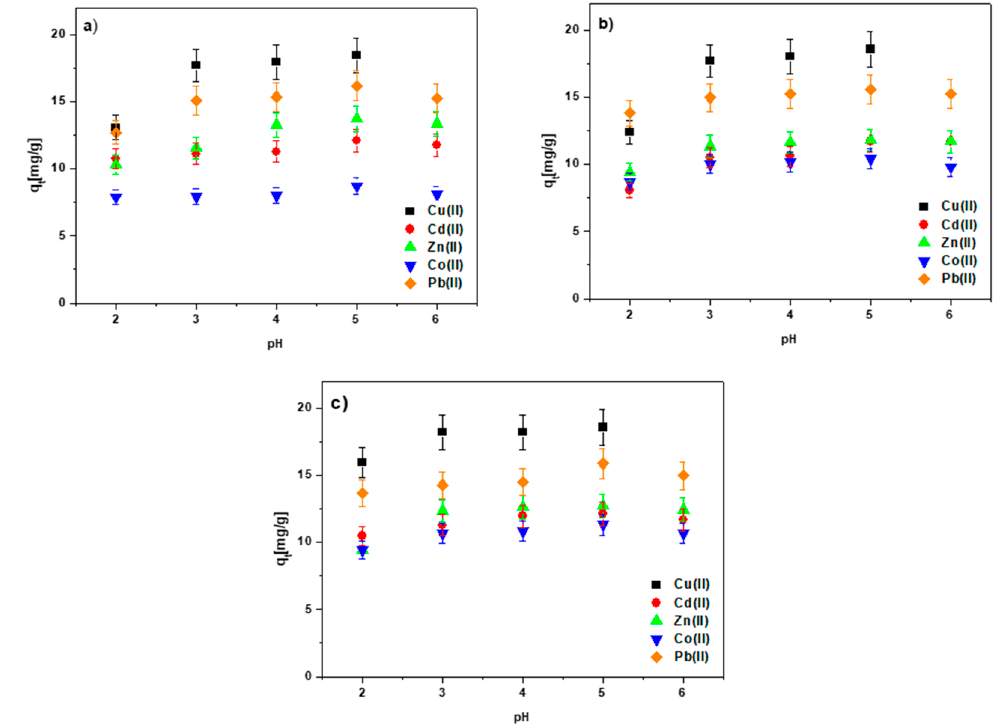
Figure 10. Effect of the pH solution on the heavy metal ion sorption on ( a ) BC-CS 1-1, ( b ) BC-CS 2-1 and ( c ) BC-CS 4-1 (C 0 100 mg/L, sorbent mass 0.1 g, pH 5, shaking speed 180 rpm, temperature 293 K).